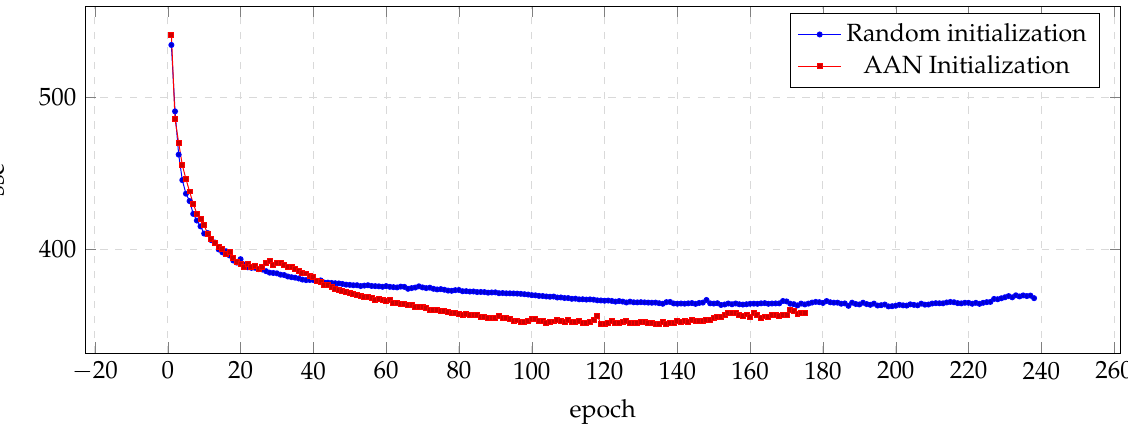
Figure 2. Evolution of the sse value for the validation set during the training process of the CLB voice.